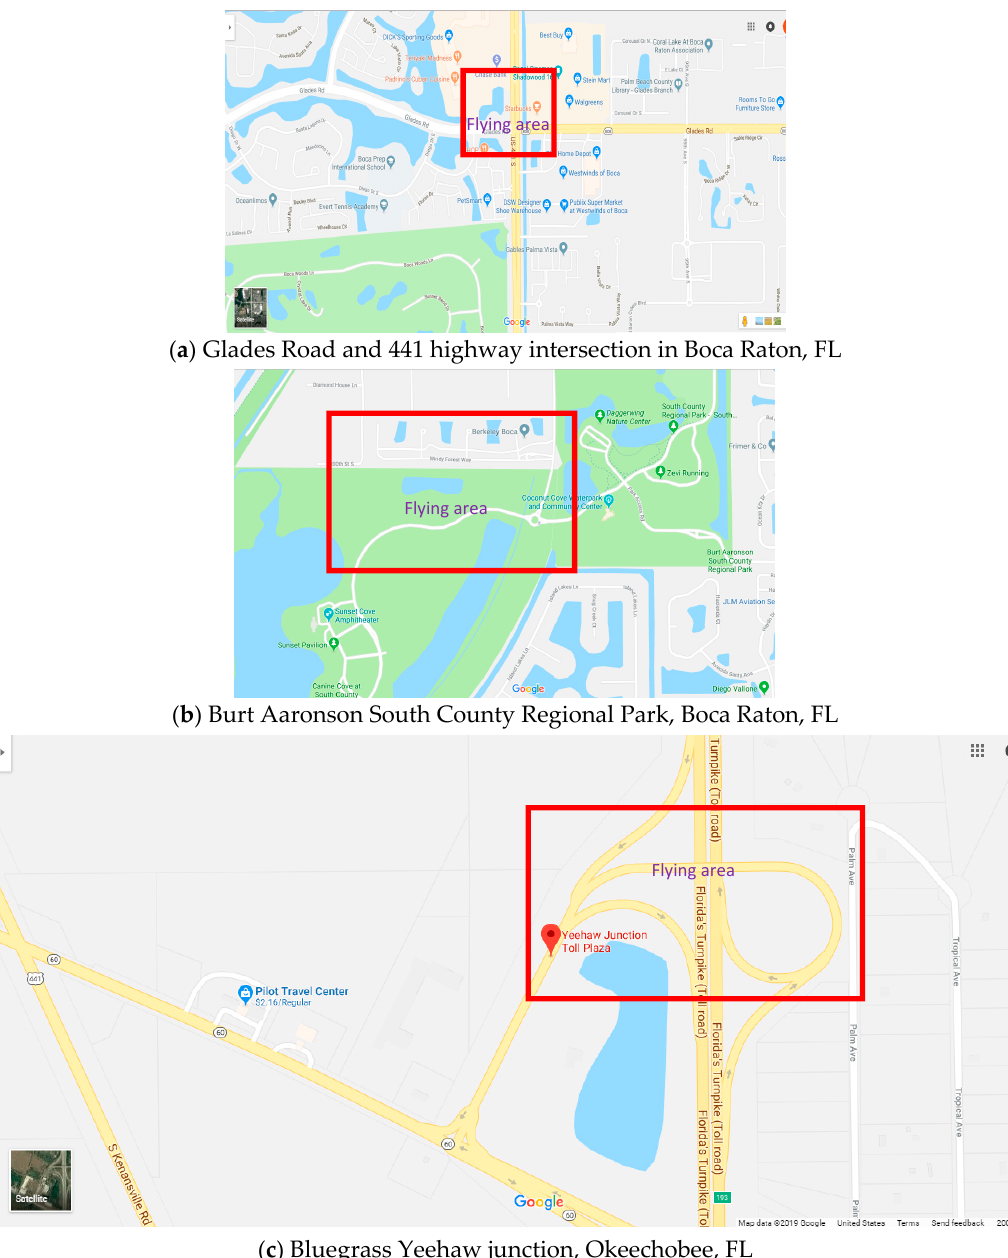
Figure 5. Google Maps data collection points.